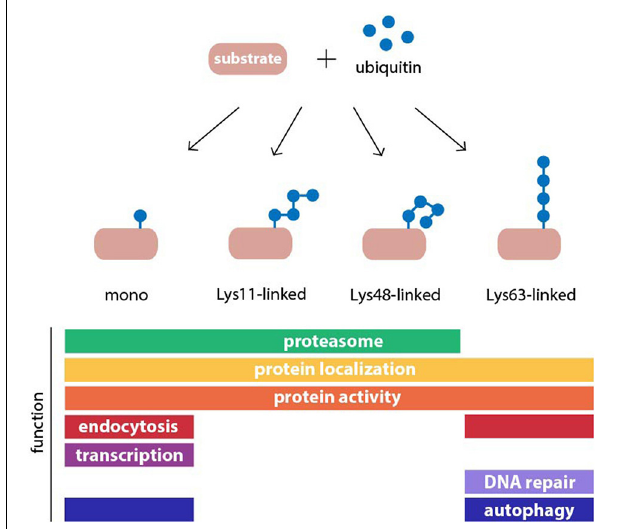
FIGURE 1 | Structure and function of common ubiquitin modifications. Ubiquitin may be conjugated to protein substrates as either a monomer or a polymeric chain, in which one of seven internal lysine (Lys) residues of ubiquitin, or the N-terminal methionine, serves as an acceptor for additional ubiquitin moieties. The type of polyubiquitin linkage dictates the topology of the resulting chain. Ubiquitin modifications can regulate protein function or act as a signal in many cellular processes. Examples for functions of monoubiquitylation, and homogenous Lys11-, Lys48-, and Lys63-linked polyubiquitin chains are